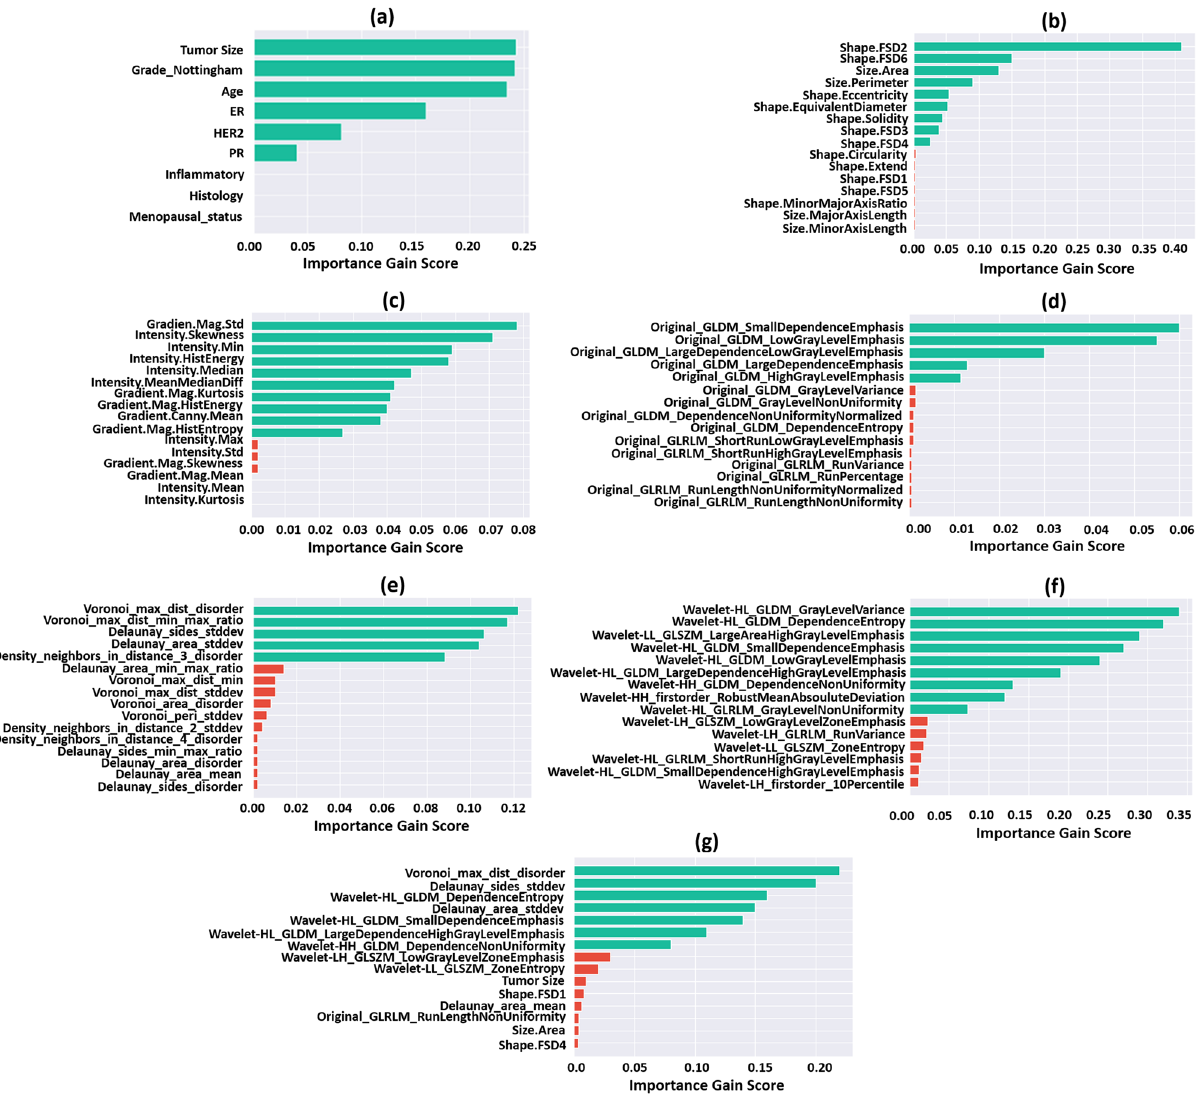
Figure 2. The importance gain score of the first 15 features with highest contribution to the predictive model for different feature subsets: ( a ) clinical, ( b ) morphological, ( c ) intensity-based, ( d ) texture, ( e ) graph-based, ( f ) wavelet, and ( g ) all features. The green bars are associated with the features included in the NAC response biomarker in each